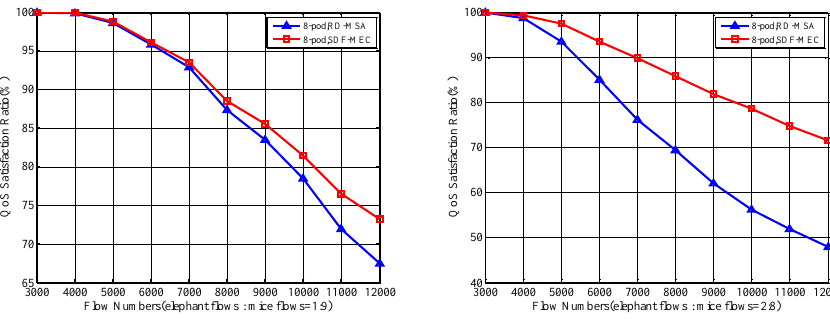
Figure 7. QoS satisfaction ratio of RD-MSA and SDF-MEC in 8-pod Fat-Tree.